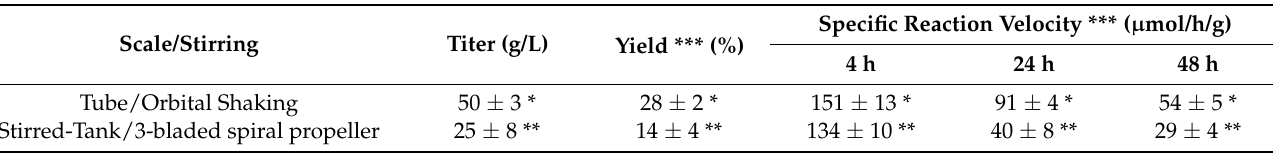
Table 5. Impact of optimized factors on SL titer after 48 h in Sorbit DES with 5 wt.% water, using Novozym 435 ® at tube and stirred-tank scales. Reaction conditions: 0.5 M vinyl laurate, 50 ◦ C and 50 g/L enzyme formulation. Specific Reaction Velocity *** ( µ mol/h/g) Scale/Stirring Titer (g/L) Yield *** (%) 4 h 24 h 48 h Tube/Orbital Shaking 50 ± 3 * 28 ± 2 * 151 ± 13 * 91 ± 4 * 54 ± 5 * Stirred-Tank/3-bladed spiral